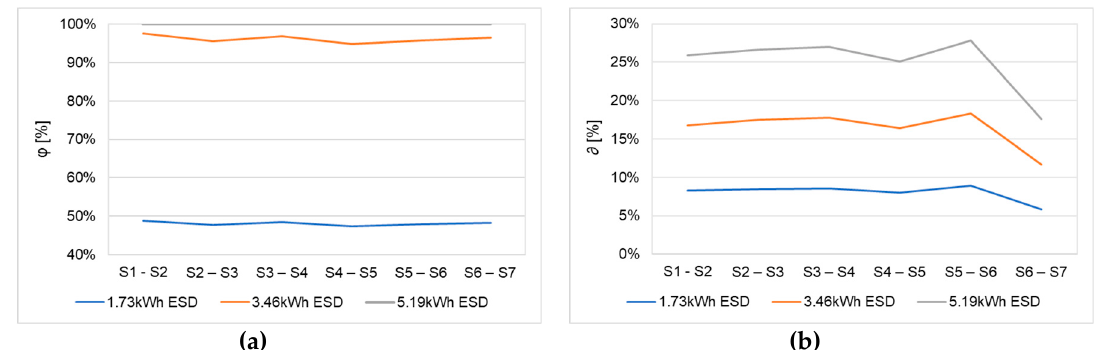
Figure 7. Simulation results for three sizes of ESD: ( a ) φ —power optimization parameter, ( b ) ∂ —energy optimization parameter.